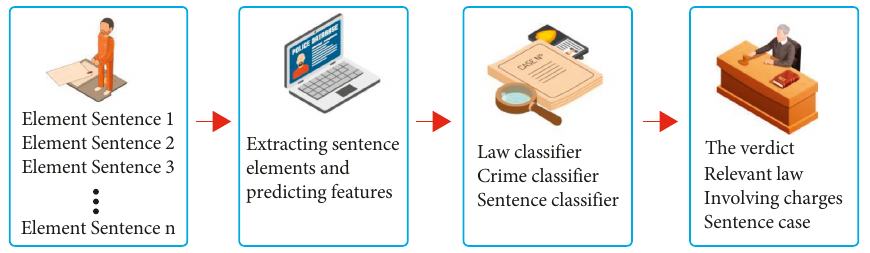
Figure 1: Legal instruments